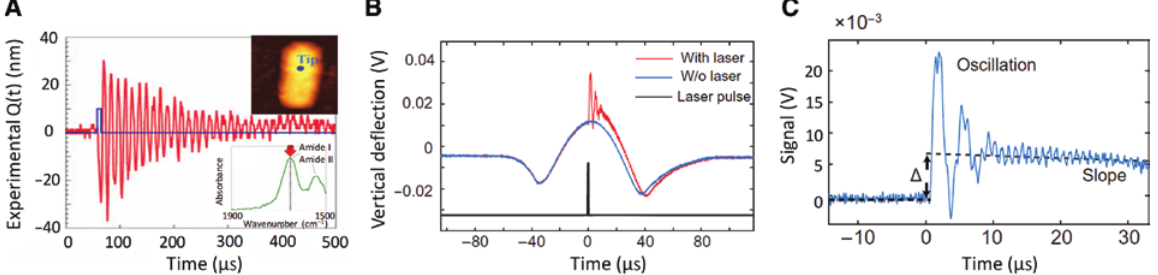
Figure 2: Detected signal of thermal expansion [23, 56]. (A) Deflection signal in contact mode; inset shows the topography of the bacterium sample; the position of AFM-tip is marked in blue dot; fourier transform infrared spectroscopy (FTIR) spectra in the right bottom inset; optical frequency is indicated by red arrow. (B) Signal by tapping mode; averaged traces of vertical deflections of the cantilever with and without laser interaction (red and blue curve). (C) Difference between the two curves in (B) (Figures adapted from Refs. [23, 56]).